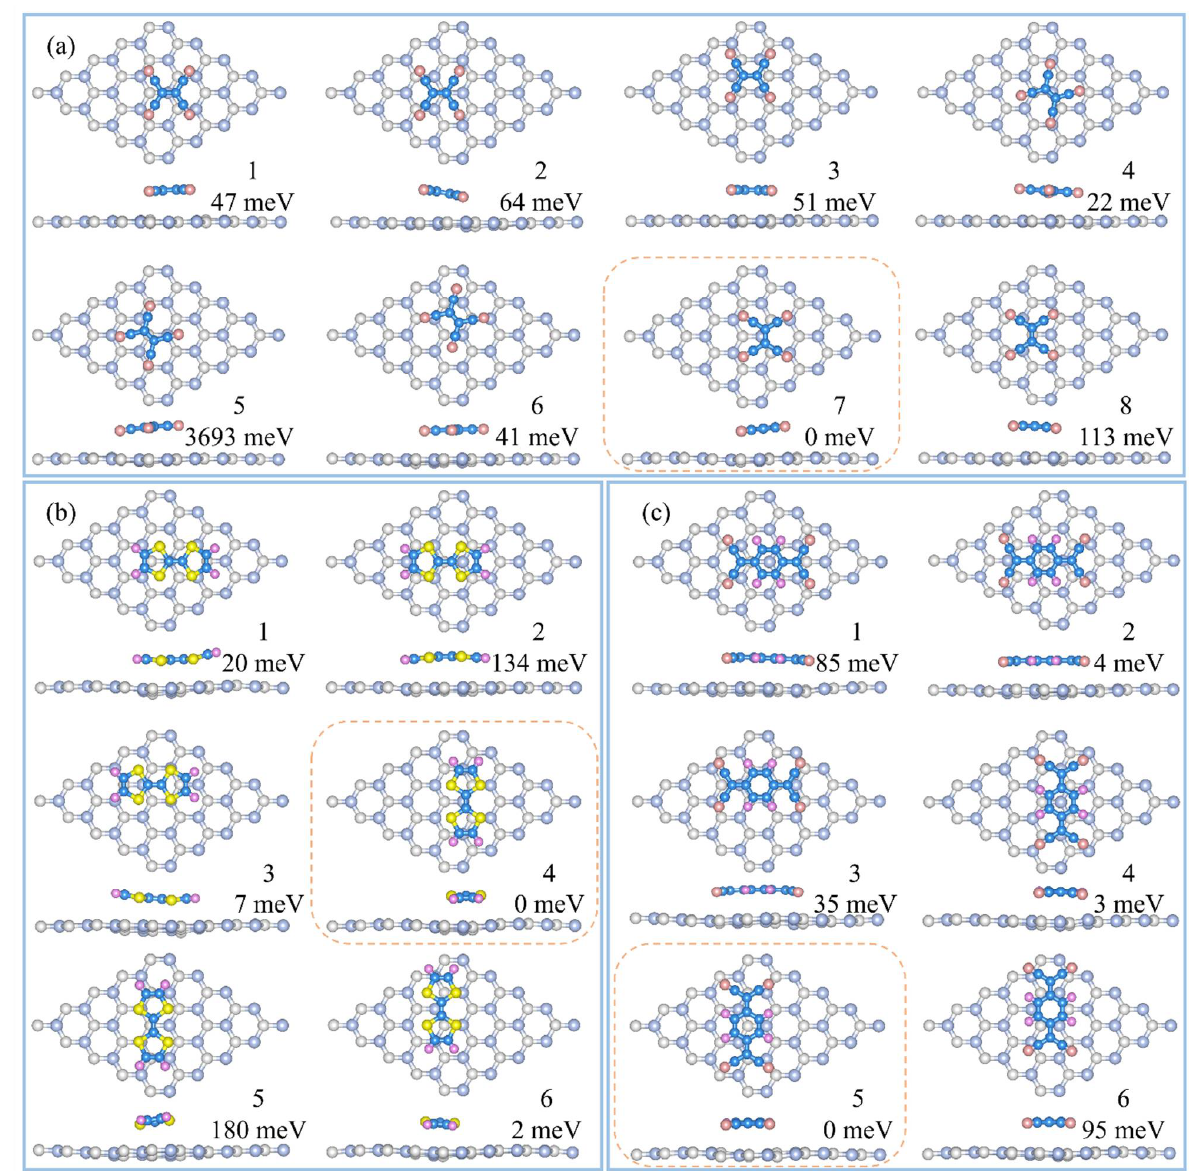
Figure 1. The adsorption configurations of ( a ) TCNE, ( b ) TTF, or ( c ) TCNQ molecules on g − ZnO. The pale purple, grey, pale red, dark blue, yellow, and pink balls represent Zn, O, N, C, S, and H atoms, respectively. The lowest energy configuration is in the orange dashed box, and its energy difference is zero.